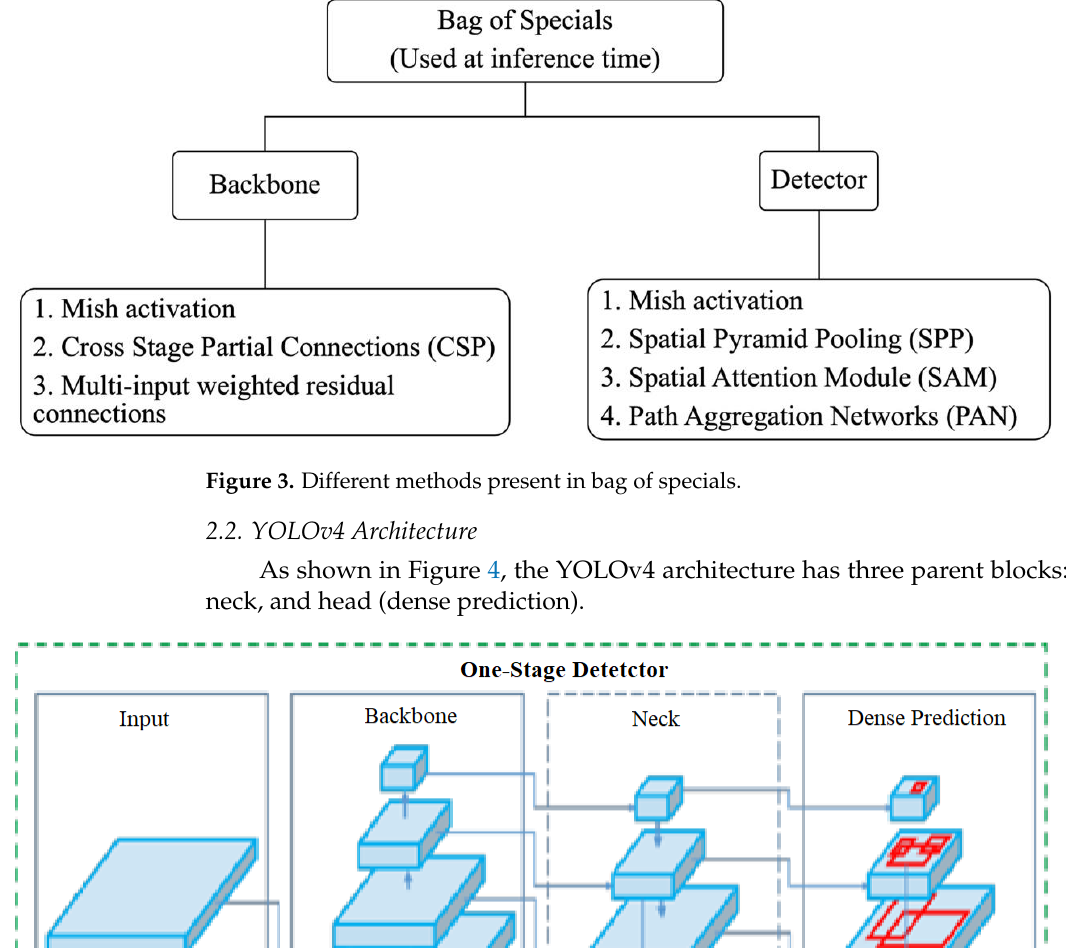
Figure 3. Different methods present in bag of specials.